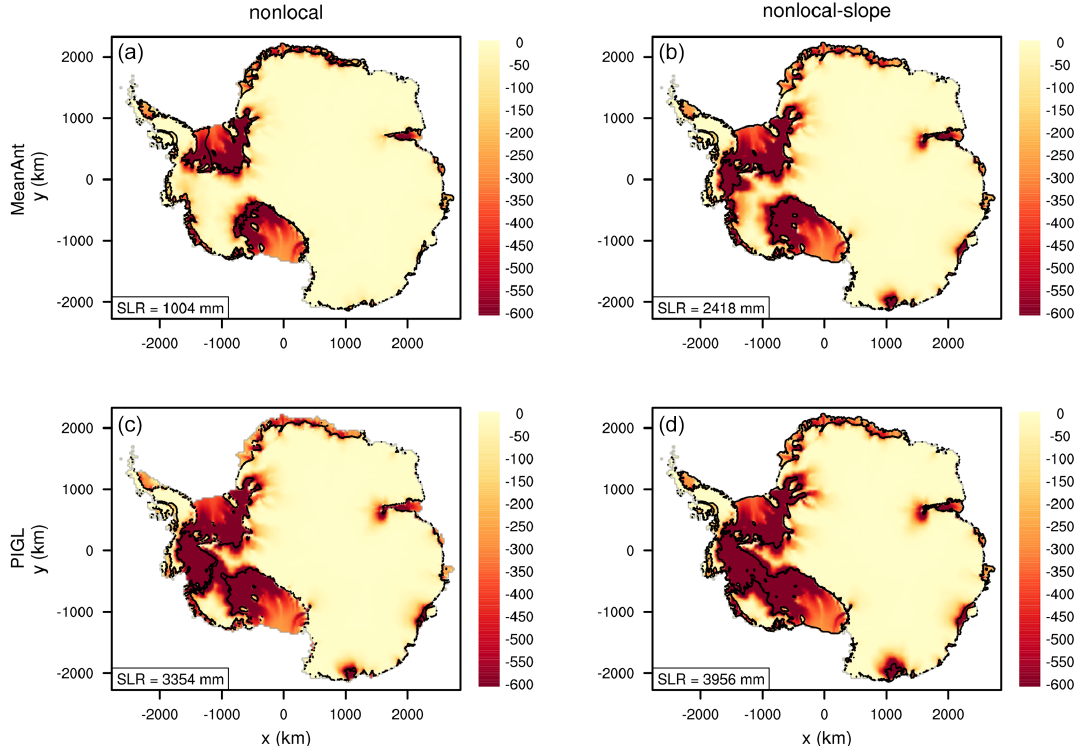
Figure 8. Same as Fig. 7, but with thermal forcing increasing by 2 ◦ C between 1950 and 2100 and held fixed thereafter. In the nonlocal runs (a, c) , black lines are absent at the present-day calving fronts of several ice shelves, indicating shelf collapse.